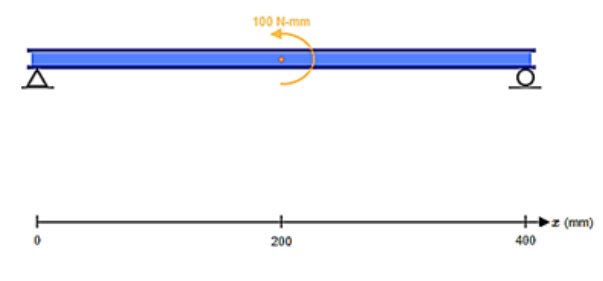
Fig. 3. Simply supported beam with a bending load at centre